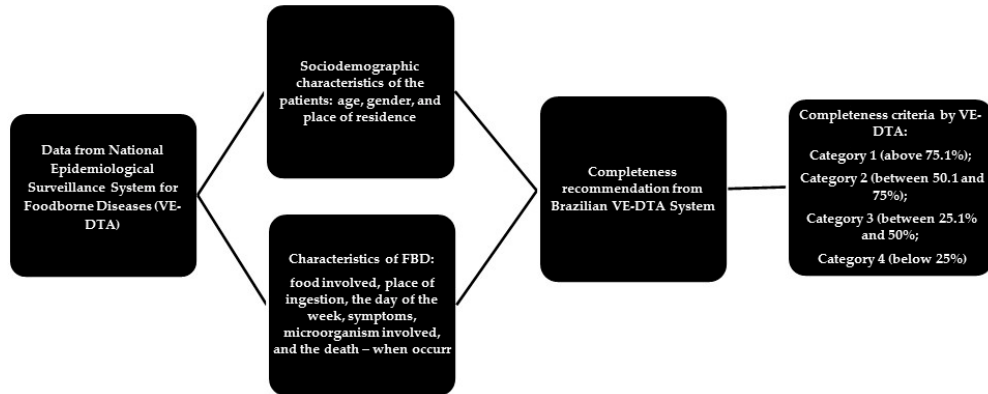
Figure 1. Stages of the data evaluation process from the Brazilian Epidemiological Surveillance System on Foodborne Diseases (VE-DTA).